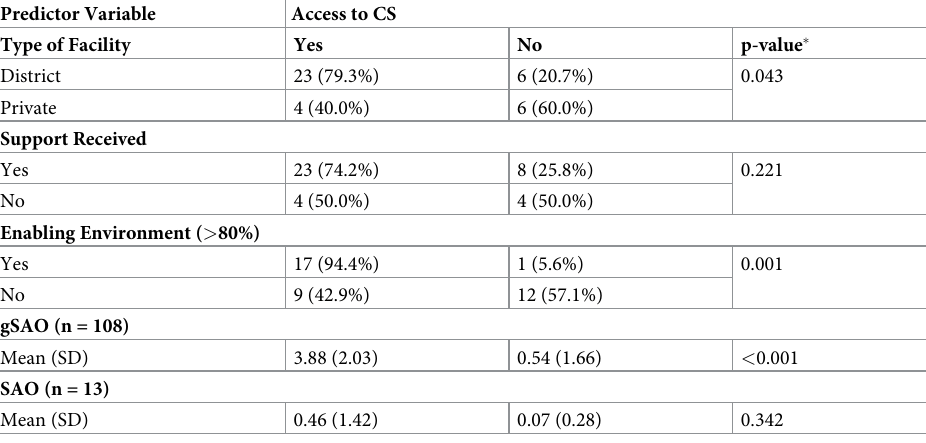
Table 1. Univariate associations predicting access to CS.